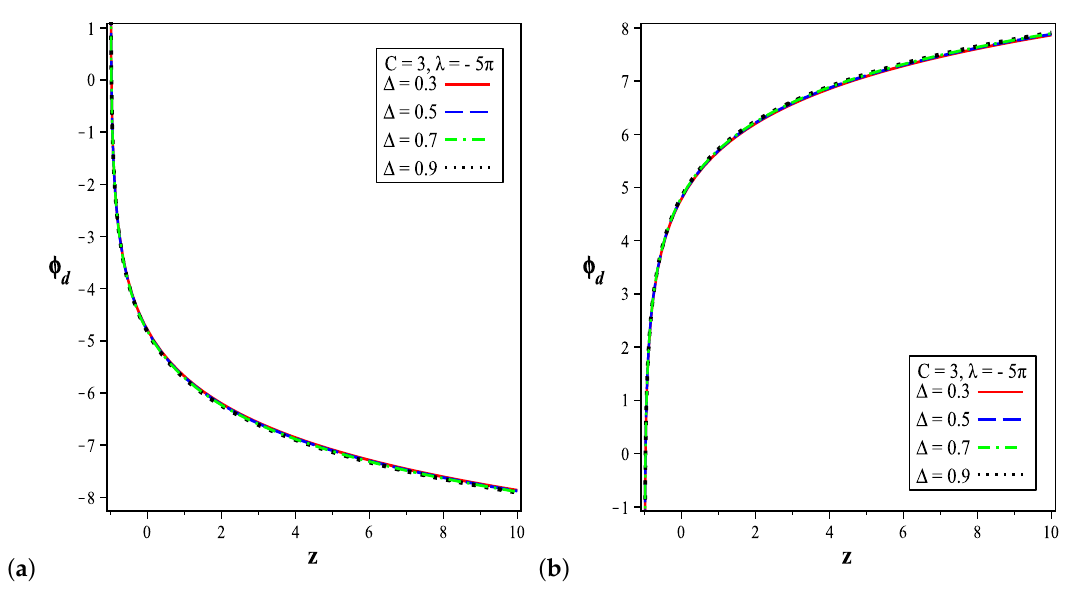
Figure 7. Depicting the nature between the redshift ( z ) and the scalar field of the Barrow holographic dilation ( φ d ) , ( a ) ( φ d ) is positive and ( b ) ( φ d ) is negative; here, C = 3 and λ = − 5 π